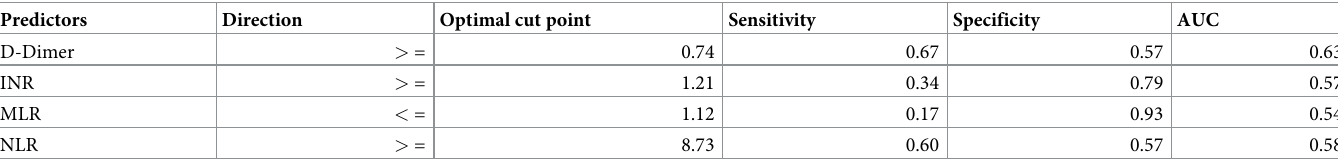
Table 4. ROC analysis of promising biomarkers for severity of